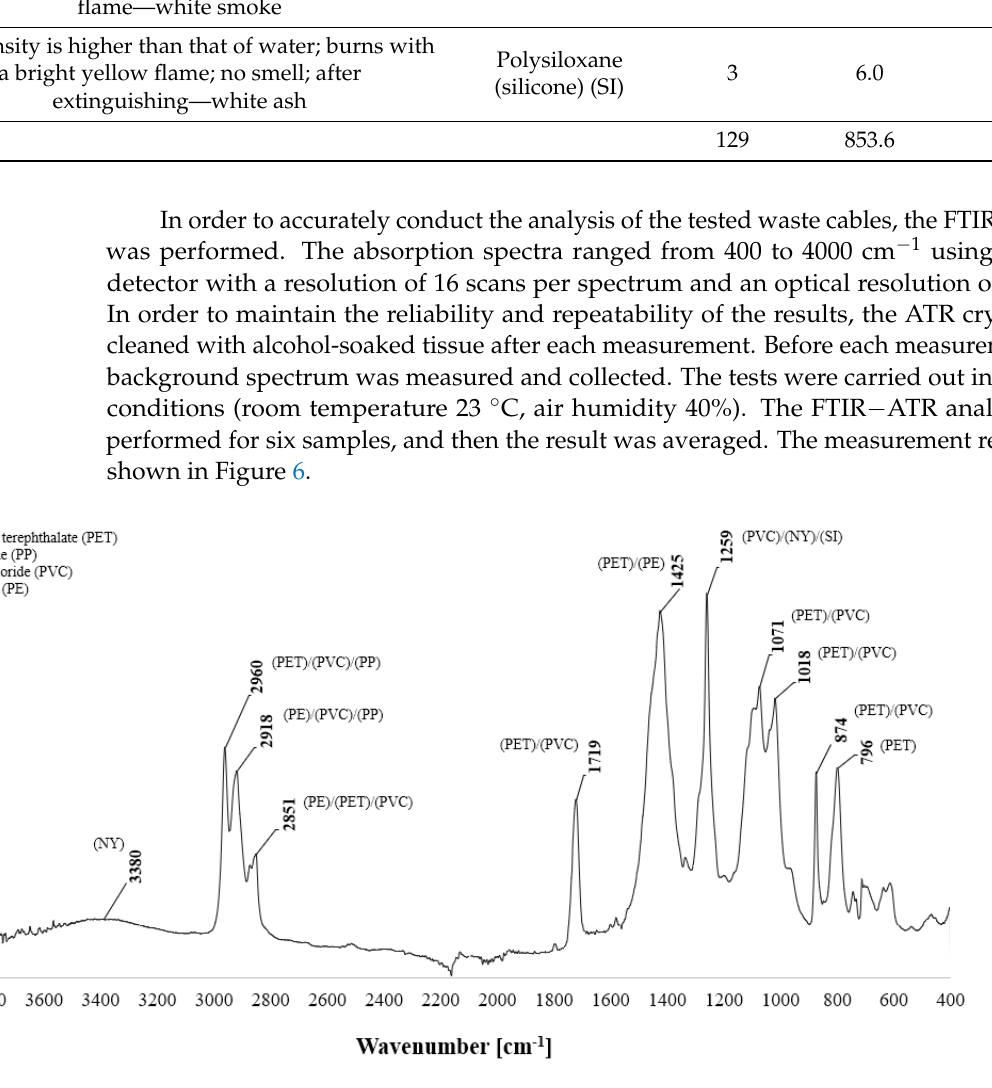
Table 1. Results of identification and mass measurements of the waste delivered for testing.